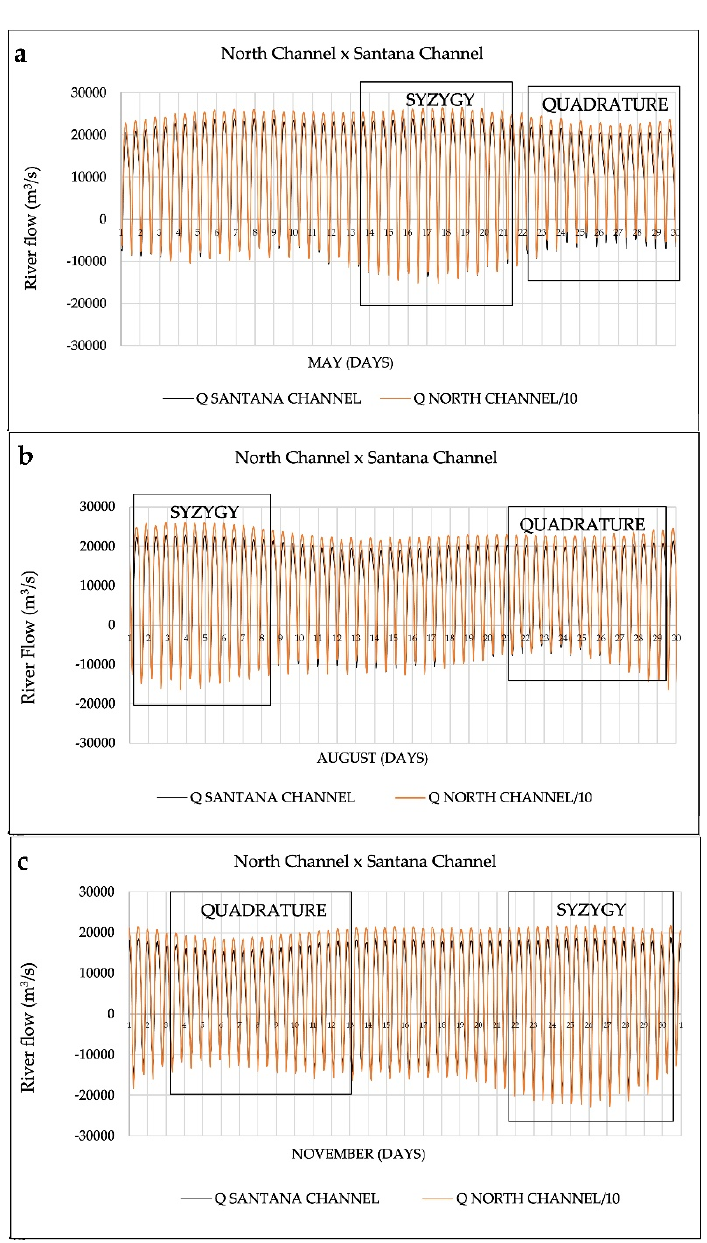
Figure 9. Flow graphs of Santana and North-Macapá channels. ( a ) May; ( b ) August; ( c ) November 2019, with emphasis on the quadrature and syzygy periods. Table 5. Maximum ebb flow and flood flow values in m 3 /s for CSA and CNM’s simulated months.